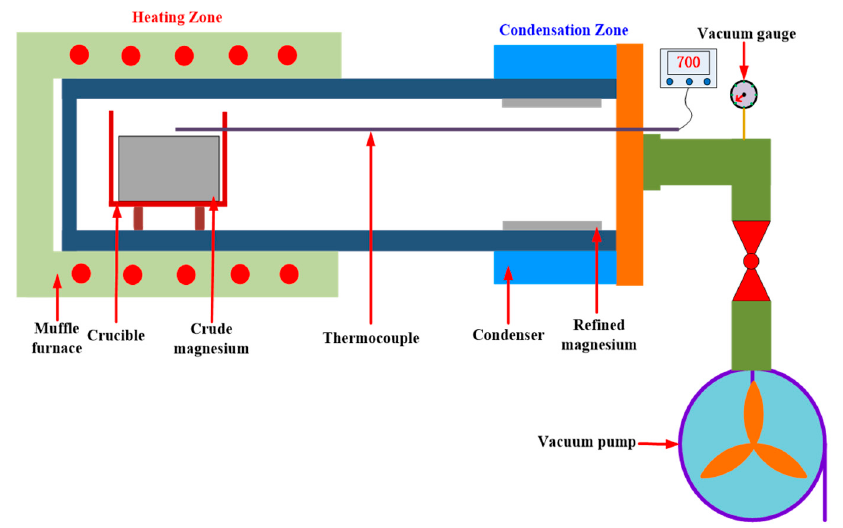
Figure 3. Schematic of the vacuum distillation device.